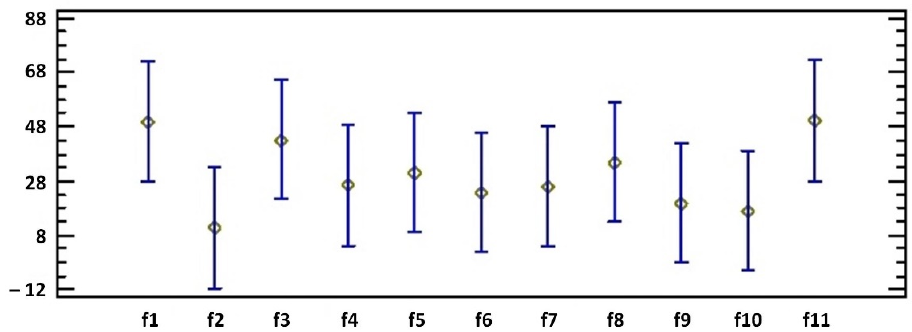
Figure 7. Means and 95% Bonferroni intervals of 1 series of experiments.